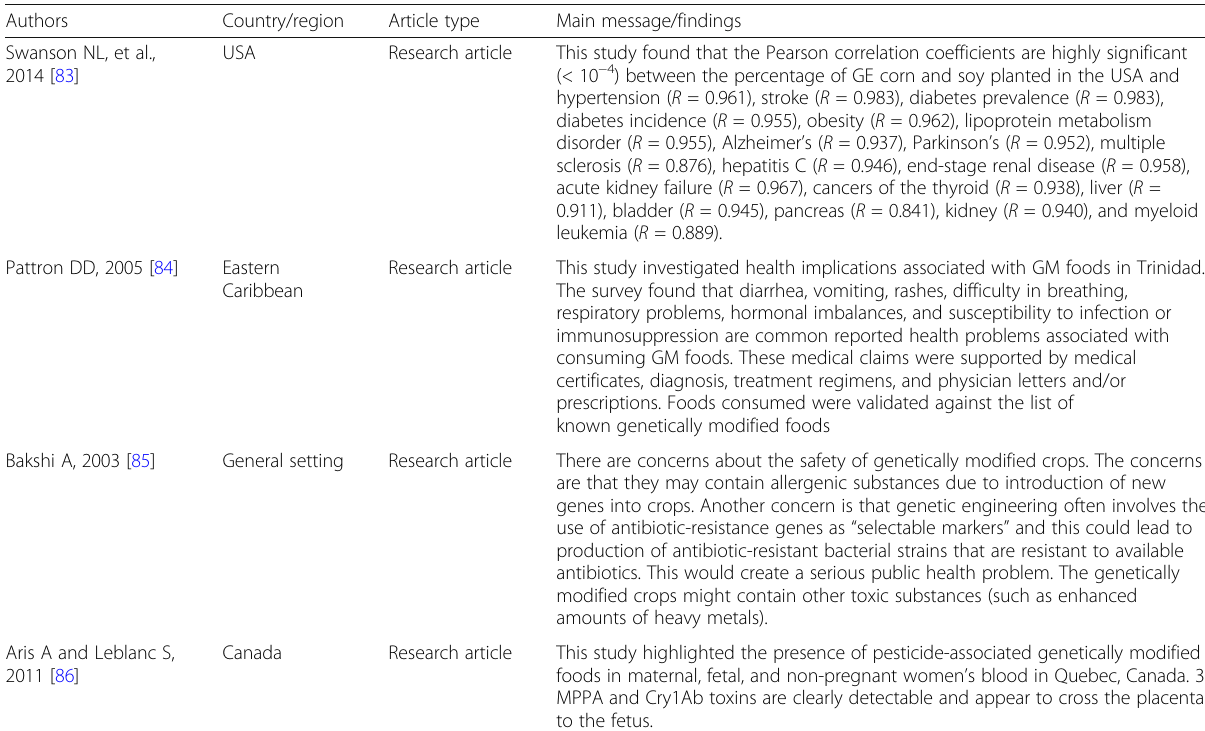
Table 8 Summary of full-text articles which reported genetically modified foods as a public risk in food